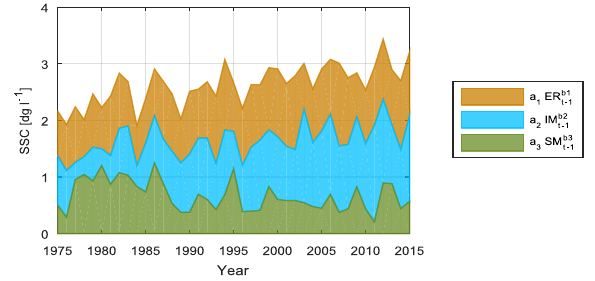
Figure 8. Mean annual contribution to SSC of ER t − 1 , IM t − 1 , and SM t − 1 simulated with the